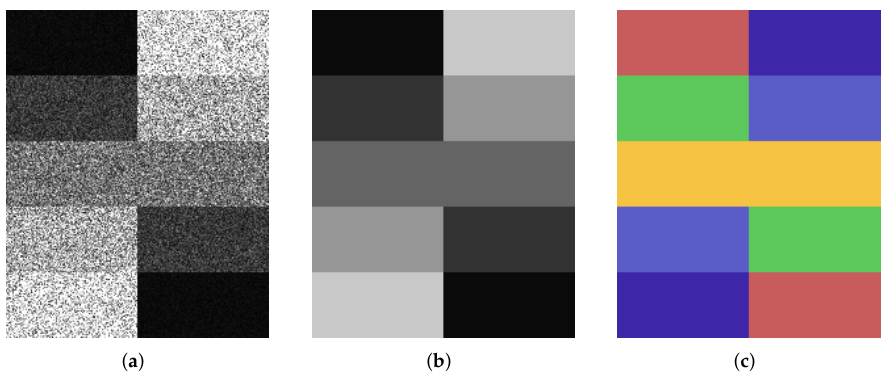
Figure 6. The simulated SAR image and ground truth. ( a ) Simulated SAR image; ( b ) ground truth with gray; ( c ) ground truth with